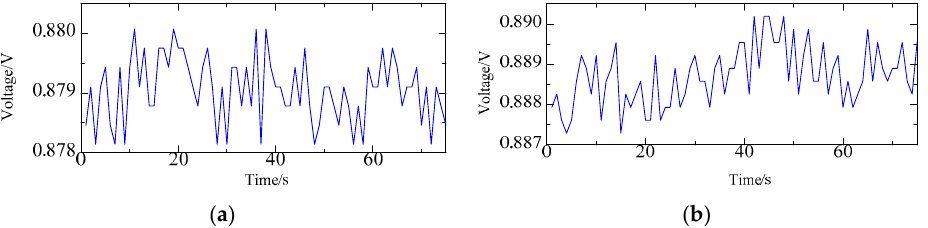
Figure 11. The noise level of probes: ( a ) Noise level of probe-1; ( b ) Noise level of probe-2.